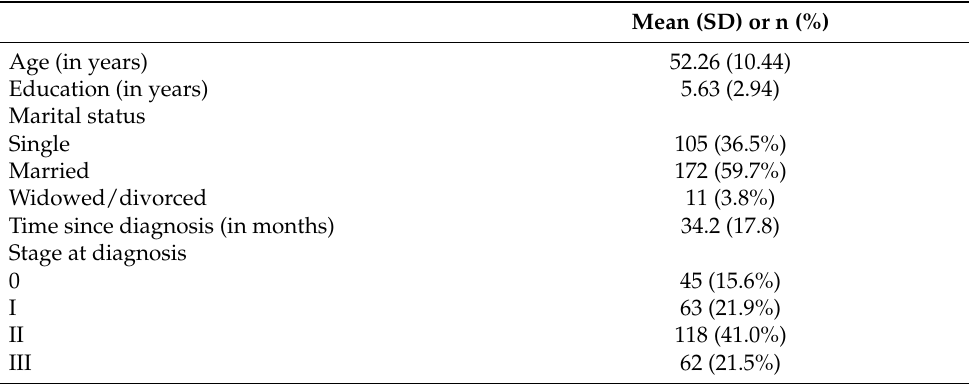
Table 1. Characteristics of the participants (N =